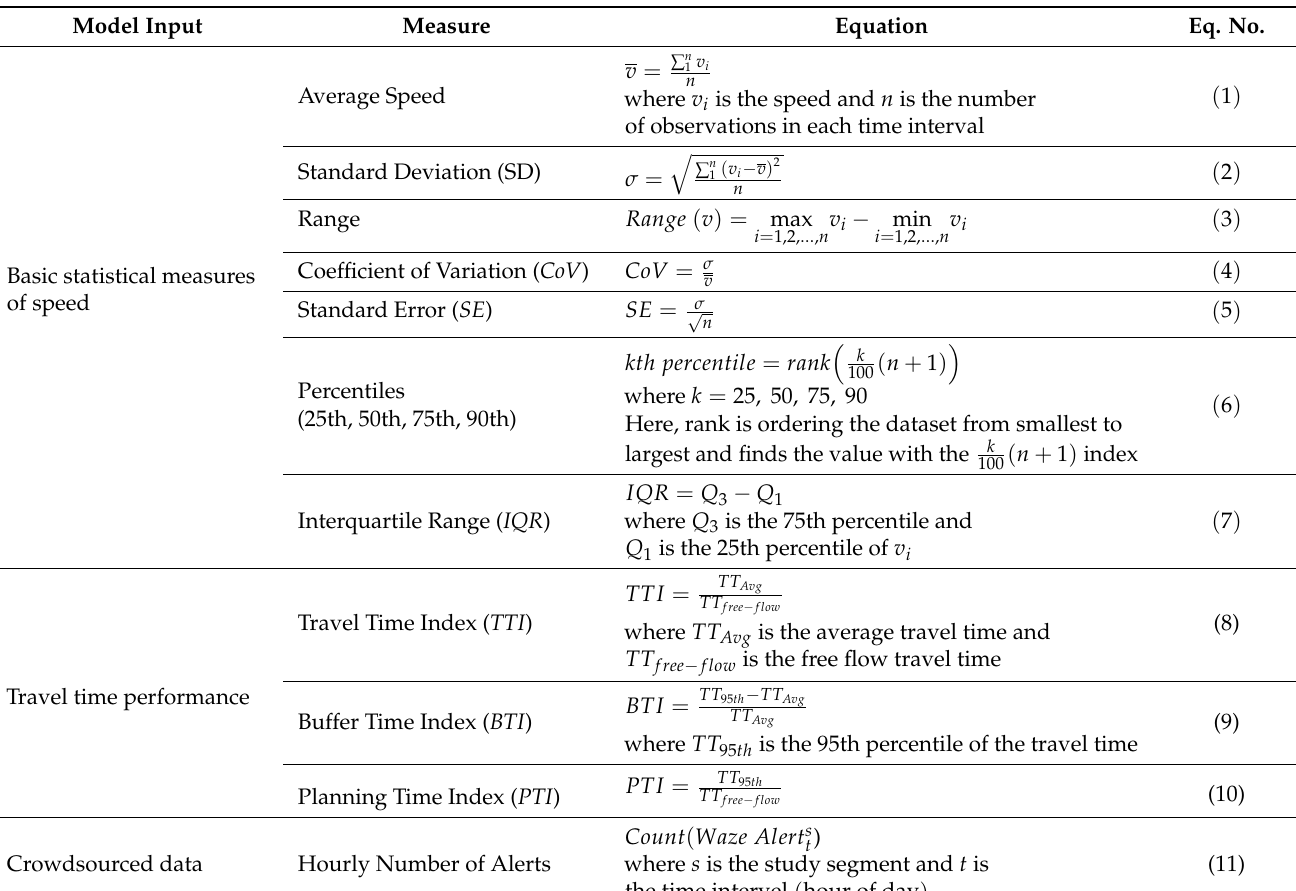
Table 3. Model input